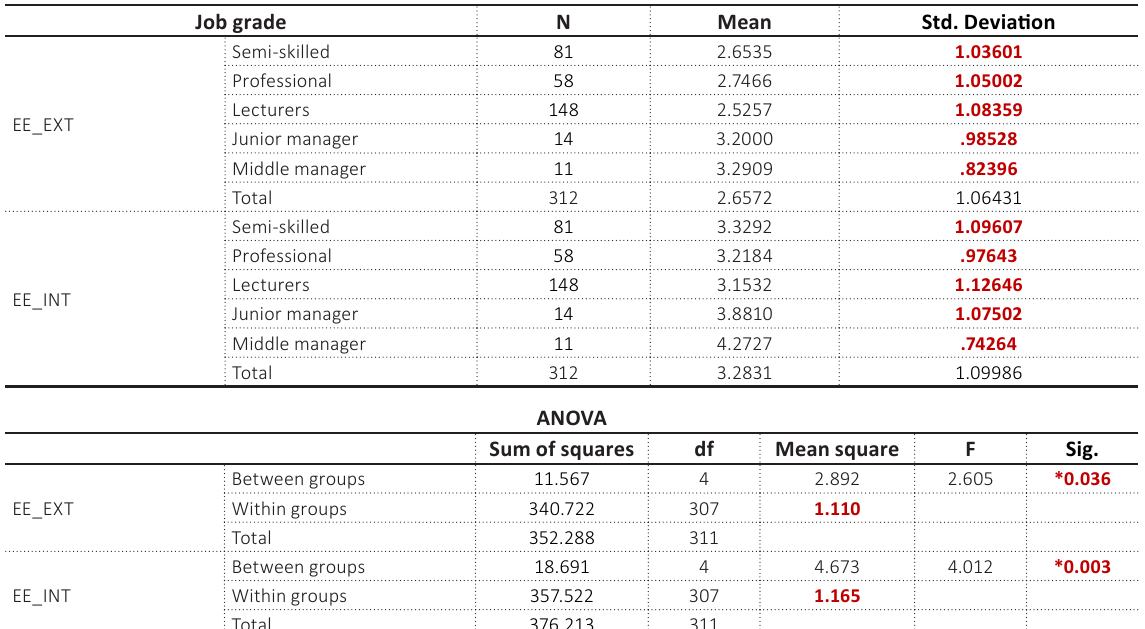
Table 3. ANOVA results for two measures across job grade